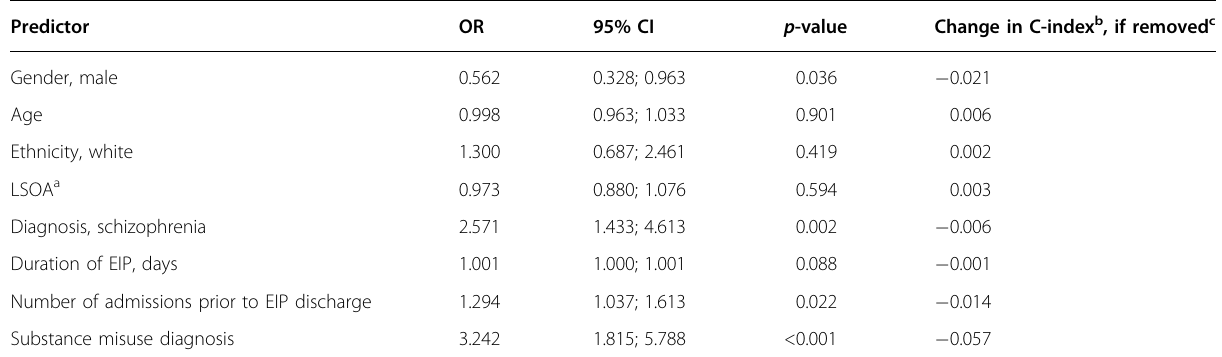
Table 2 Logistic model performance of the development dataset.